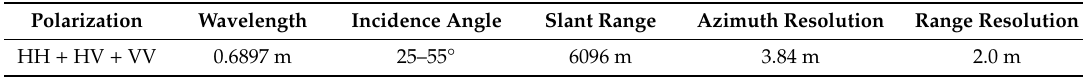
Table 2. Parameters of the F-SAR airborne